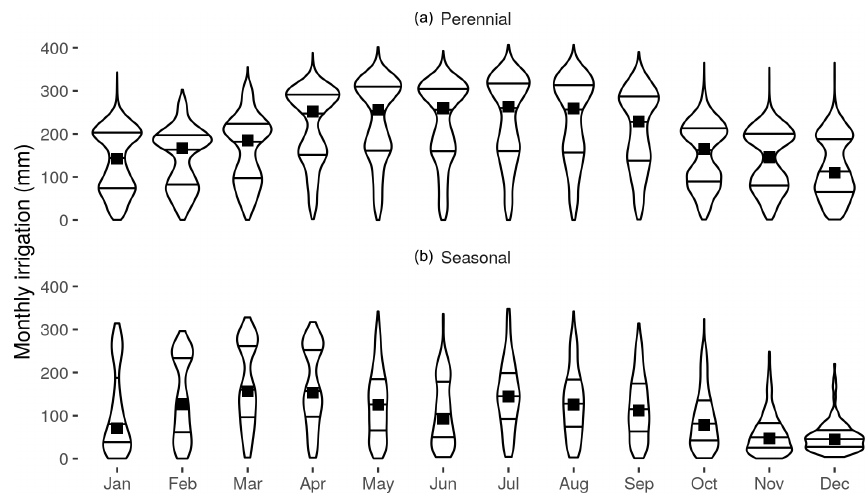
Figure 10. Monthly irrigation statistics (mm) for perennial (a) and seasonal (b) fields. The black squares show the average values of monthly irrigation among the same types of fields in the region (4509 perennial fields; 974 seasonal fields). The violin plots show the distribution of monthly irrigation values, which range from 0 (no irrigation) up to 406mmmonth − 1 (i.e., 13.5mmd − 1 ). Horizontal lines show the 25%, 50% (median), and 75%